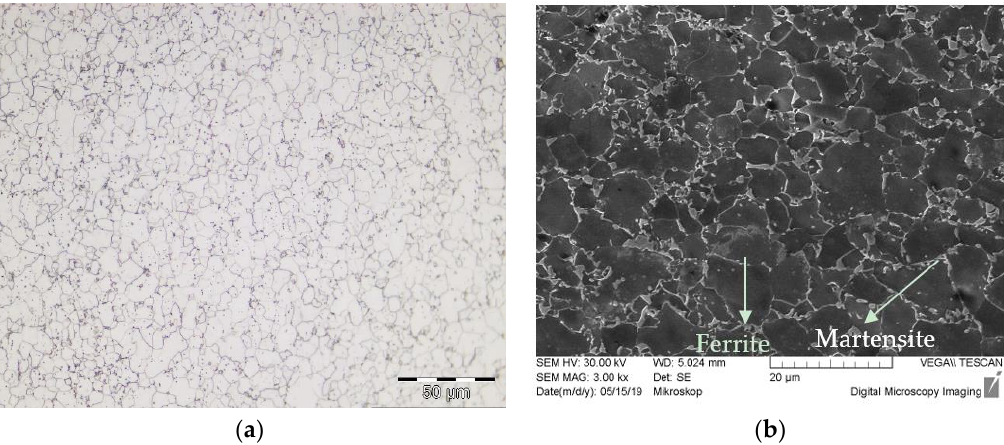
Figure 1. Microstructure of DP450 steel: ( a ) Optical microscope image; ( b ) Scanning electron microscope image.